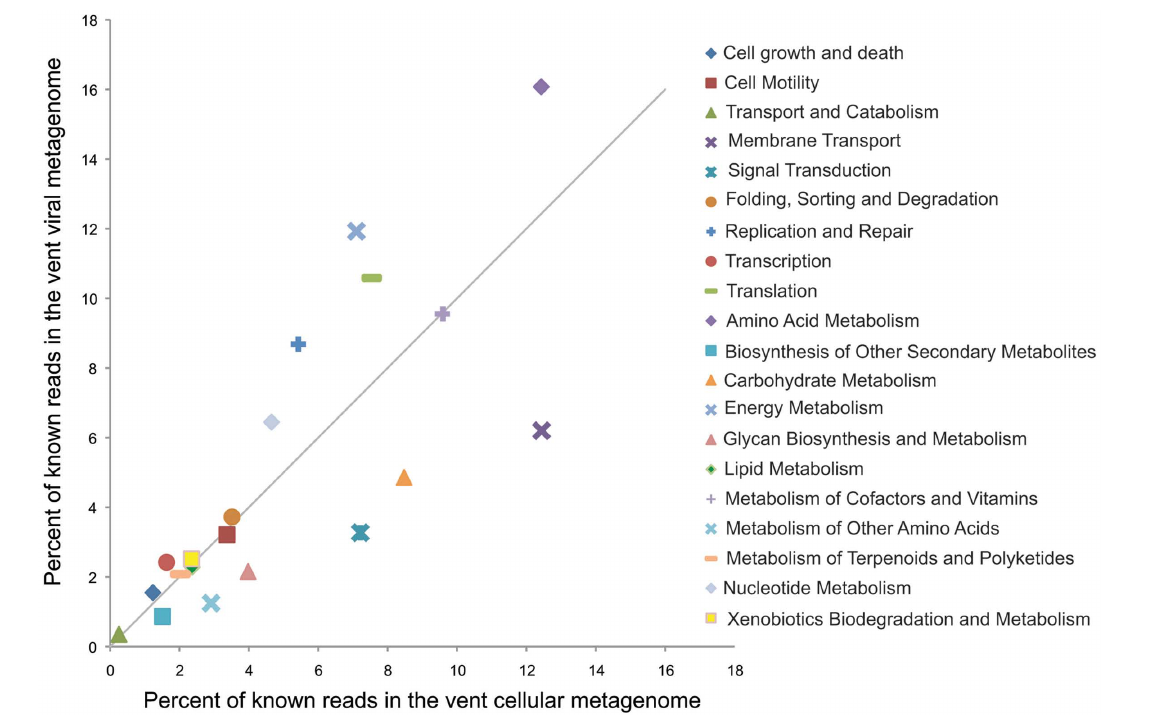
FIGURE 4 | Relative percentages of reads matching gene categories in the marine vent virome (Anderson et al., 2011) and the hydrothermal vent cellular metagenome by Xie et al. (2011). The solid line indicates a 1:1